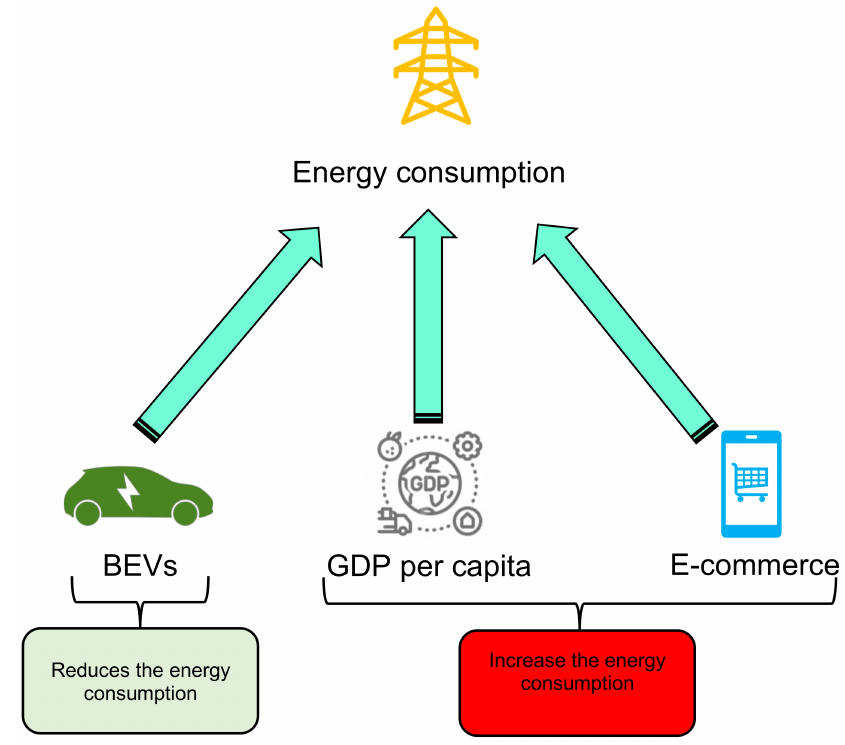
Figure 4. Summary of the variable’s effect. The authors created this